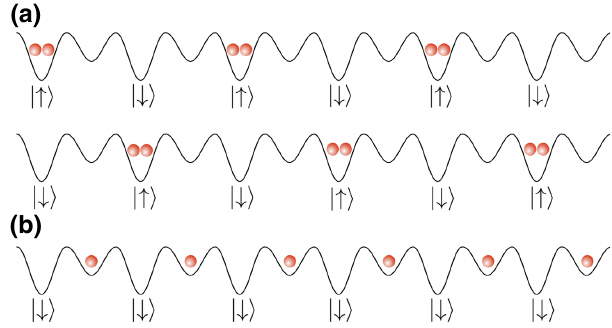
FIG. 3. A schematic of two phases in the G l = 0 gauge sector in (a) the m → ∞ limit and (b) the m → −∞